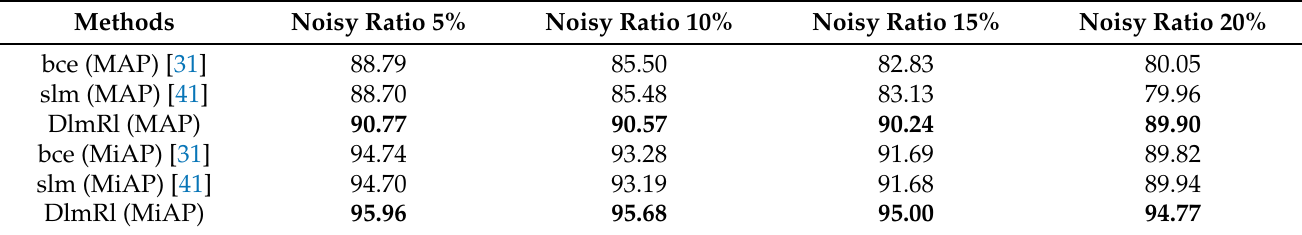
Table 1. MAP and MiAP score (%) of different methods on VOC2007.